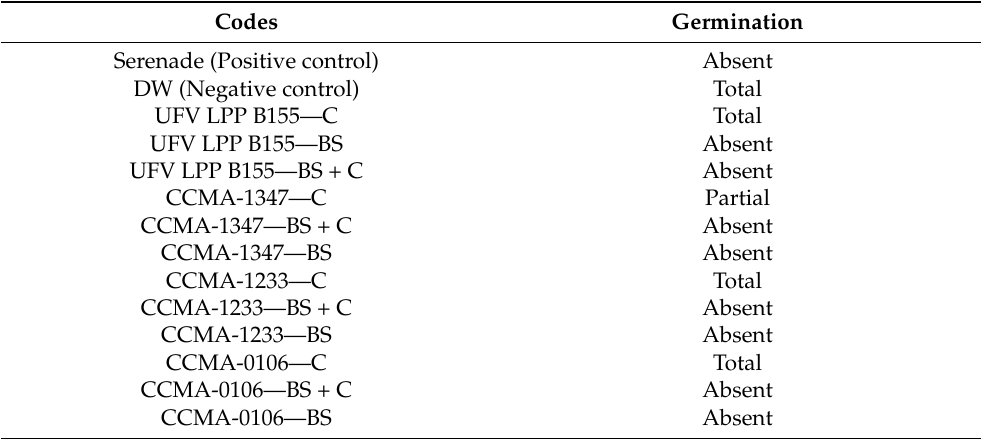
Table 4. Germination of Phakopsora pachyrhizi spores in the different